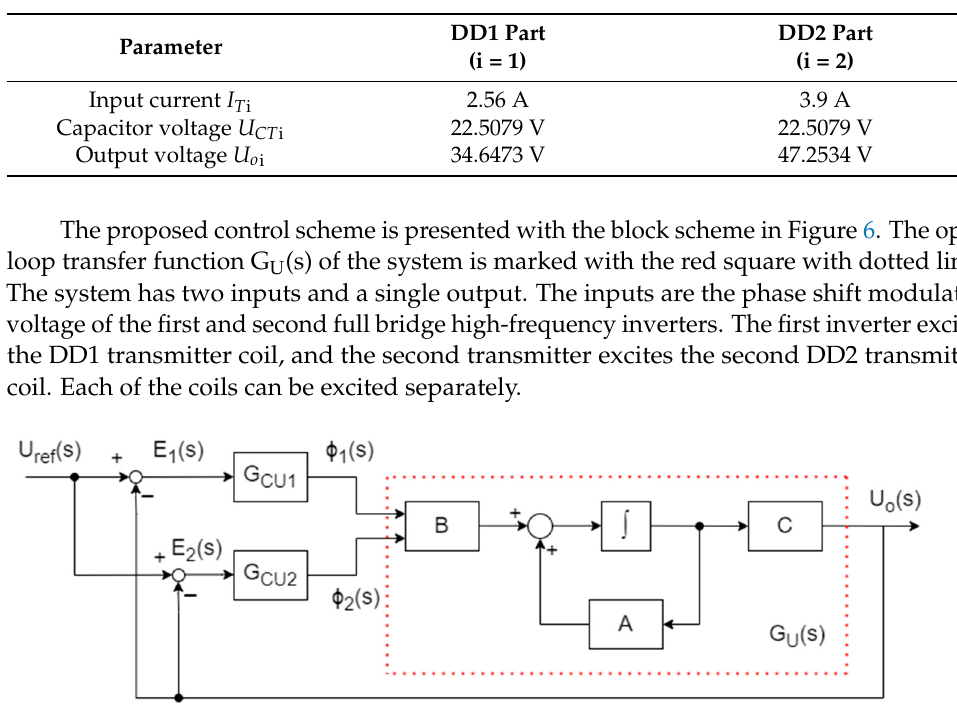
Figure 6. Block scheme of the voltage control for the proposed IPT system using a double DD coil structure.